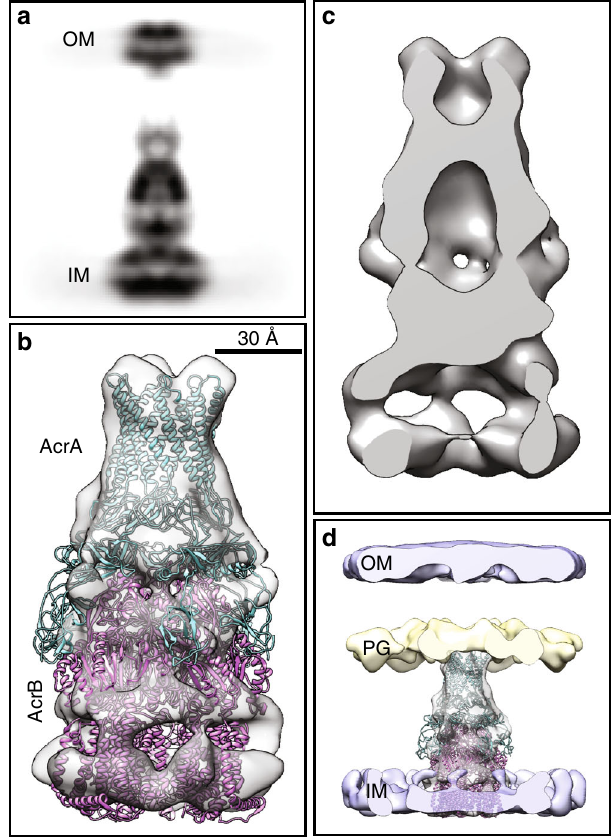
Fig. 3 In situ Cryo-ET structure of the AcrAB subcomplex. a The side-view projection of the subtomogram average of the AcrAB subcomplex in presence of antibiotics. b Isosurface rendering of a fi tted with the cryo-EM single-particle model (PDB: 5V5S). c A slice through the density map of b . d Isosurface rendering of b overlaid with density map of the cell envelope